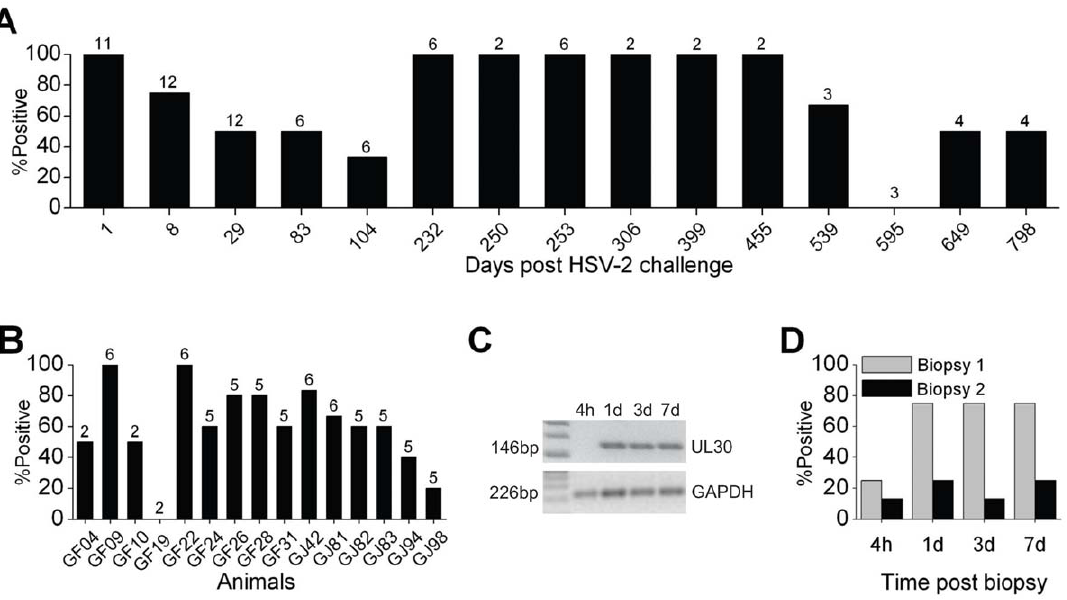
Figure 1. HSV-2 shedding after vaginal exposure. (A) Vaginal swabs were collected at the indicated times after HSV-2 exposure and HSV-2 DNA shedding was determined by measuring the presence of HSV-2 UL30 DNA by PCR. Each sample’s integrity was verified by amplifying the GAPDH gene. The percentage of samples positive for HSV-2 UL30 DNA at the indicated time points is shown relative to the primary exposure to HSV-2. The numbers above the bars indicate the number of animals tested at each time point. (B) The DNA shedding is shown for each animal, where the numbers above the bars denote the number of times that animal was sampled during the study. (C,D) 3–6 (Biopsy 1) or 9–12 (Biopsy 2) months after co-challenge vaginal and cervical biopsies were taken from 8 animals and vaginal swabs were collected 4 hours, 1, 3 and 7 days later. (C) Representative gels resolving the amplified 146 bp HSV-2 UL30 gene and the 226 bp GAPDH gene control are shown for a set of samples from one animal. (D) The percentage of HSV-2 DNA positive animals for the indicated samples are provided (n=8 for each biopsy).